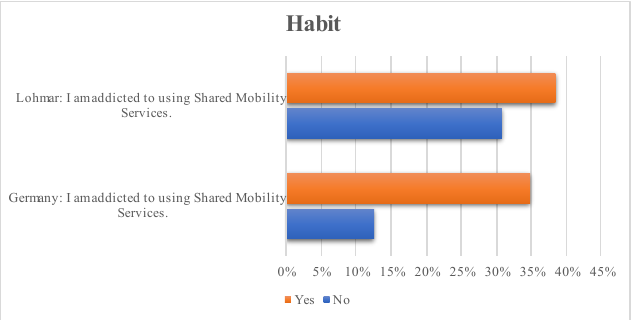
Figure 8. Habit (HT): Germany vs. Lohmar.